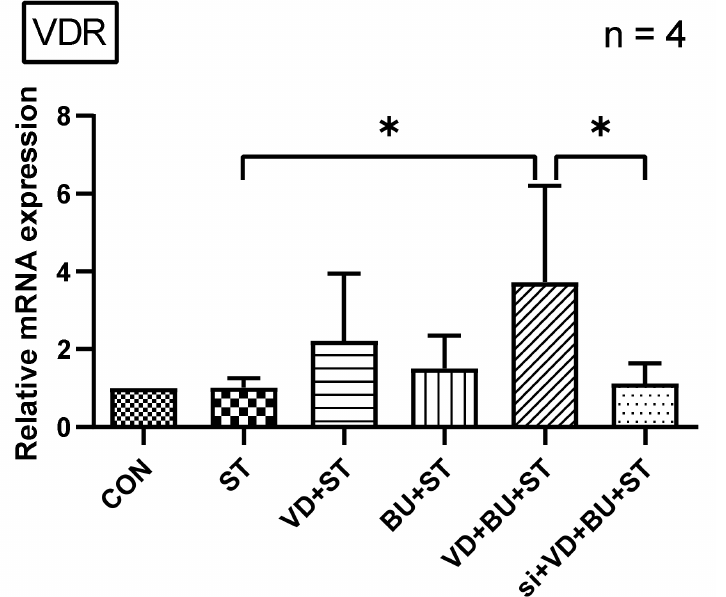
Figure 4. The synergistic effects of butyrate and active vitamin D on VDR mRNA expression in Salmonella -infected Caco-2 cells. Based on an in vivo study showing a combination of butyrate and 1,25D3 enhanced cecal VDR mRNA expression. Using an in vitro study, Caco-2 cells were not infected (CON) or infected by a constant concentration of S. typhimurium wild-typed strain SL1344 (ST), in the presence of butyrate (BU), 1,25D3 (VD), or a combination of both (VD + BU). Total RNA was extracted from Caco-2 cells and real-time quantitative PCR was performed to measure the amount of VDR mRNA. The results of the mRNA expression levels are depicted as means ± SEM of at least three independent experiments. * p <